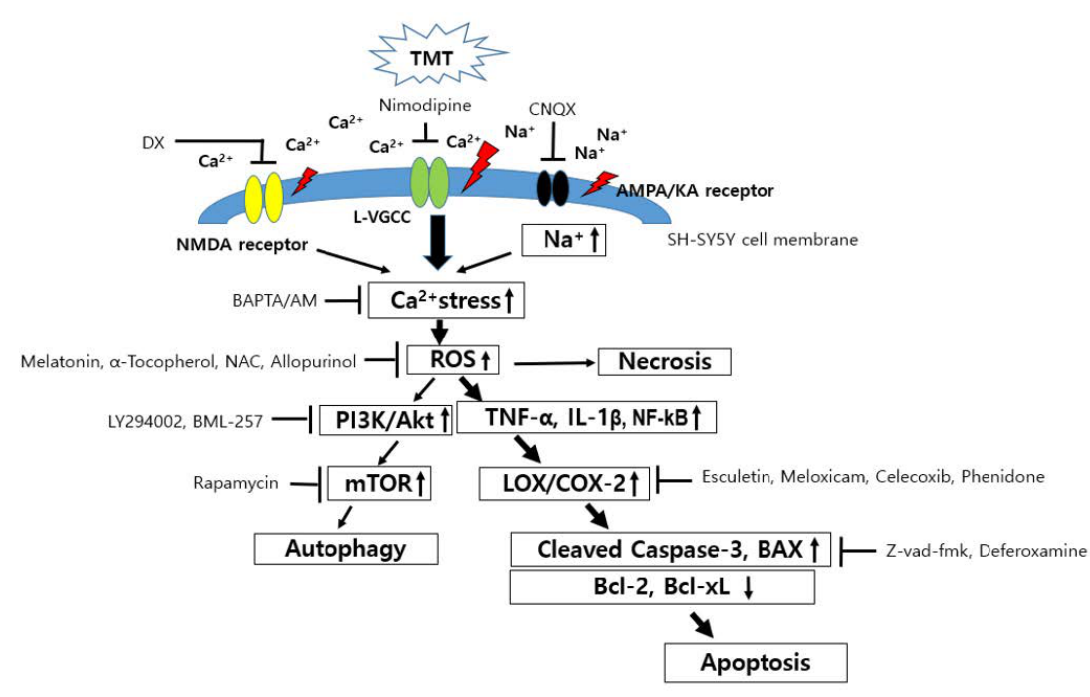
Figure 12. Hypothesis of a TMT-induced neurotoxic mechanism in human neuroblastoma SH-SY5Y